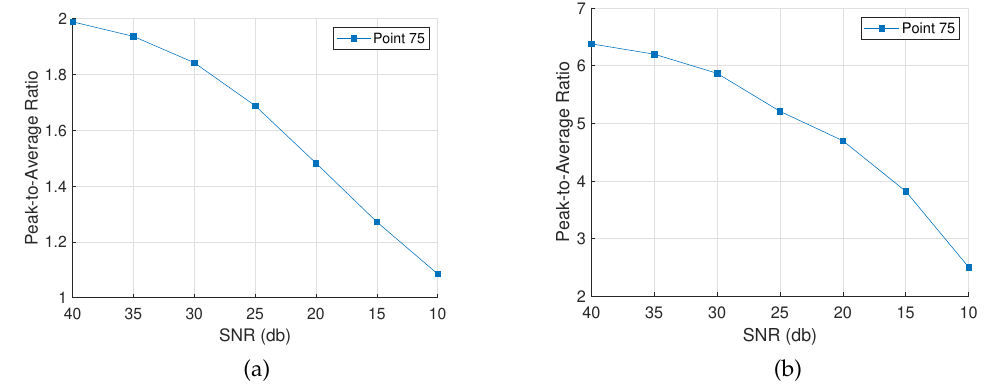
Figure 10. Peak-to-Average Ratio for damage configuration M 1 with varying SNR. ( a ) Complex Group Lasso. ( b ) Adaptive Complex Group